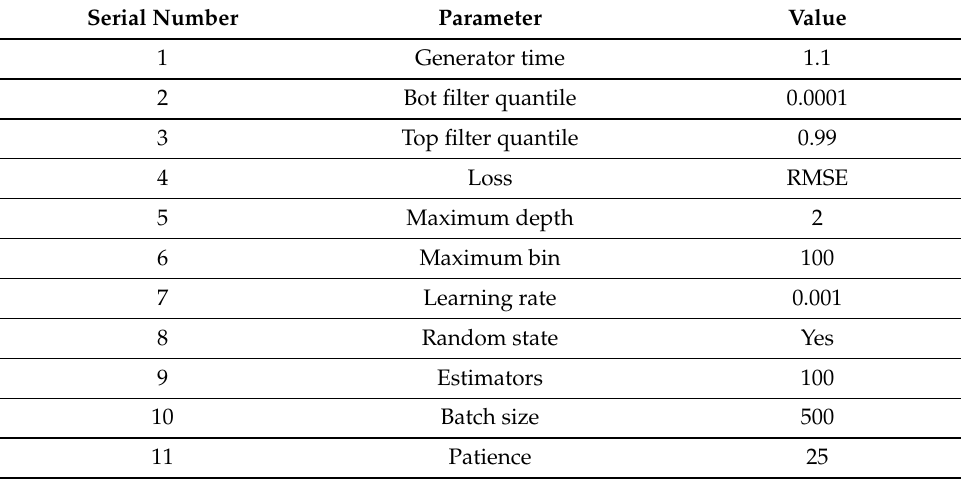
Table 3. Hyperparameters and their values used in GAN for data generation. Serial